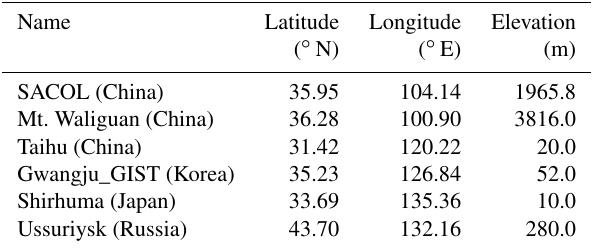
Table 2. Information on selected AERONET